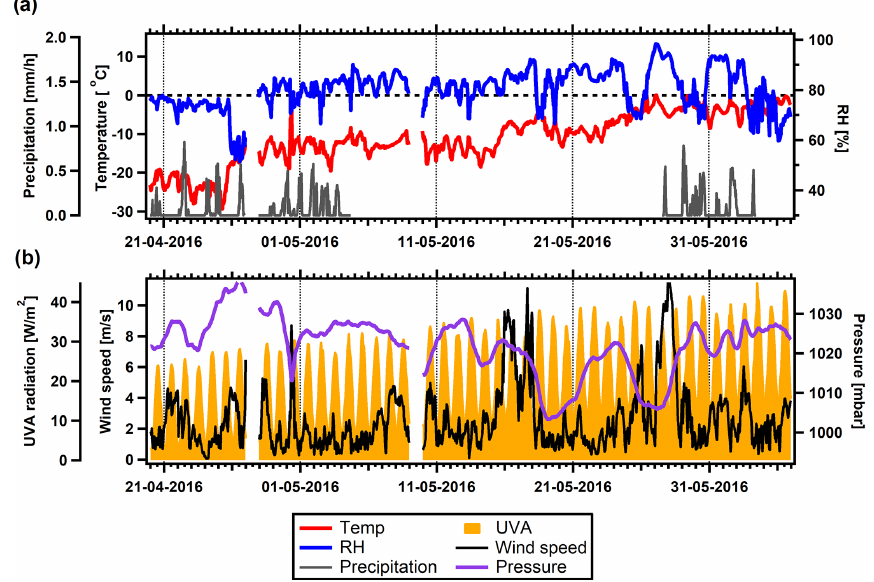
Figure 2. Overview of meteorological conditions during the spring field study. (a) Temperature, RH, and precipitation. The dashed line indicates 0 ◦ C. (b) UVA radiation, wind speed, and atmospheric pressure.